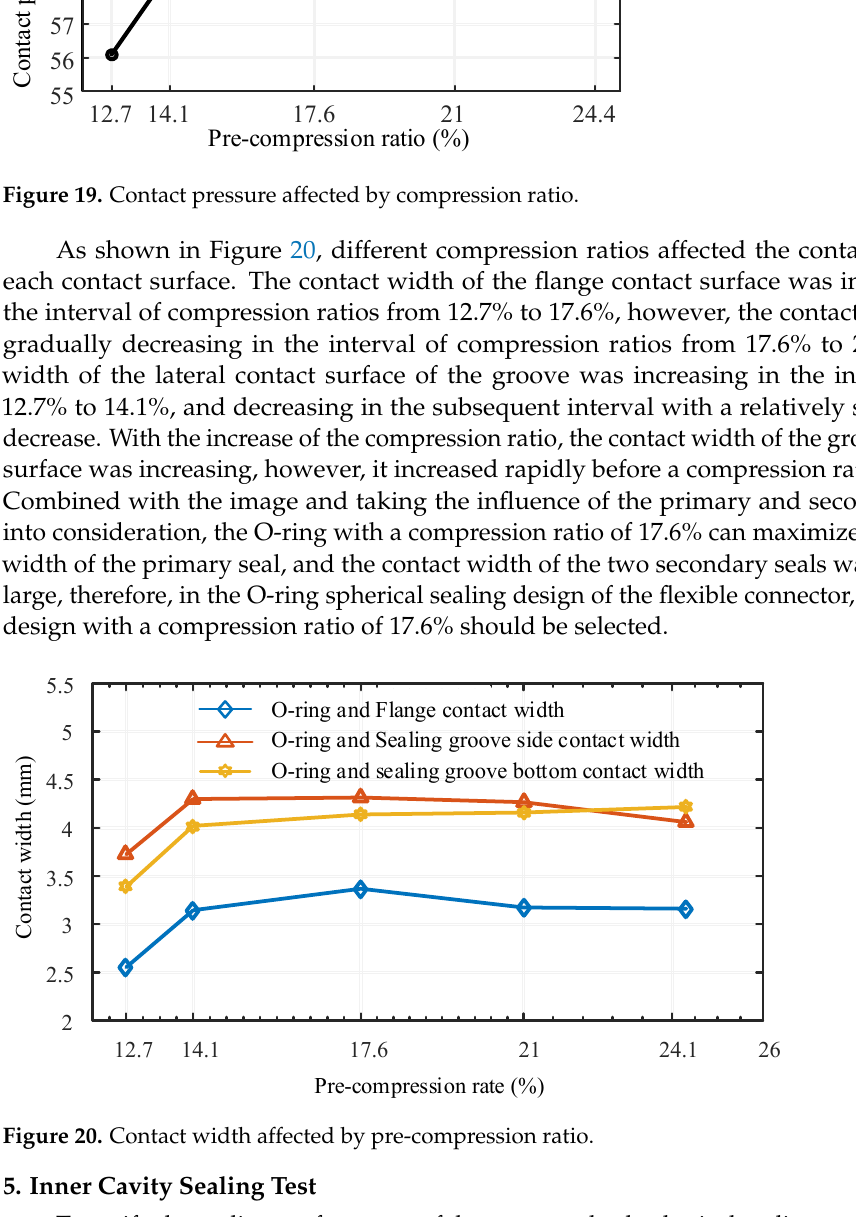
Figure 18. Equivalent stress affected by compression ratio.